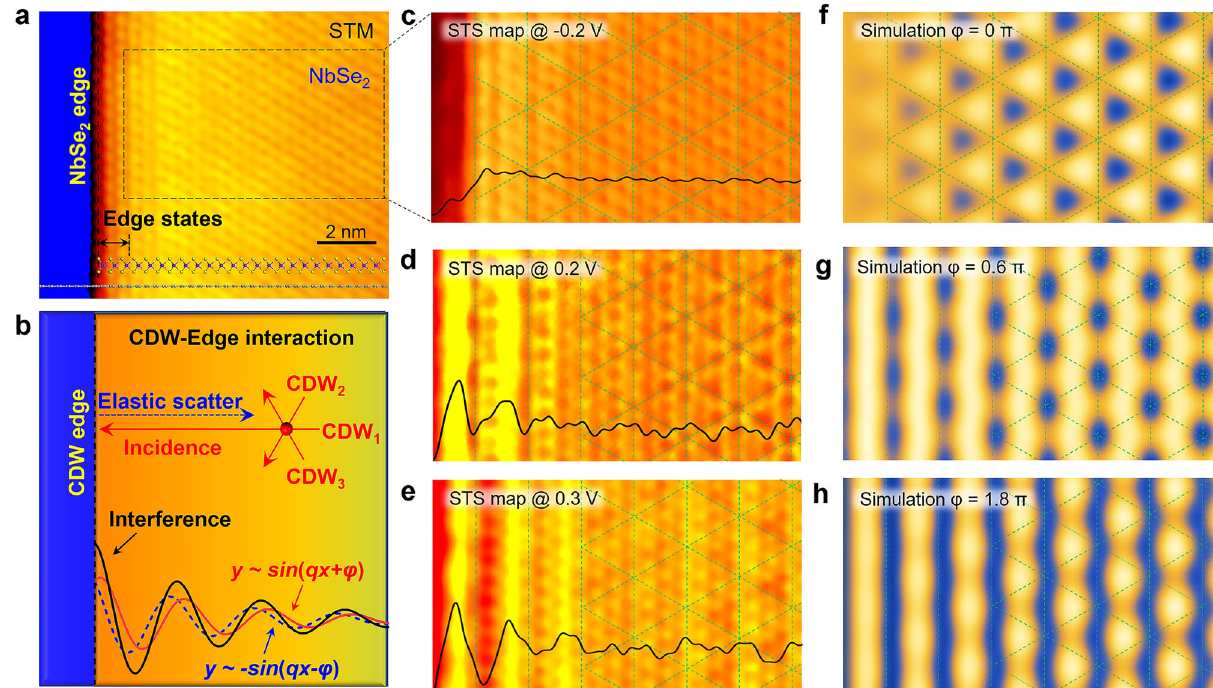
Fig. 4 Charge-density-wave (CDW) orders on the interior of monolayer (ML) NbSe 2 near the well-ordered zigzag (ZZ) edges. a Scanning tunneling microscopy (STM) images at the ZZ edge of ML NbSe 2 . The entire regions exhibit clear 3 × 3 superlattices. The range of edge states are marked in the panel. b Schematic diagram of edge states and edge-CDW interference interactions at the CDW edge. The in-plane CDW modulations can be described as the sum of three individual plane waves CDW 1,2,3 , which are connected by a threefold rotation symmetry. In the direction perpendicular to the edge, the incident and elastic scattered waves can be simpli fi ed to sin ( kx + φ ) and − sin ( kx − φ ), respectively. The interference of the plane waves by the incident and elastic scattered processes results in the stripe-like charge density, depending on the phase φ of the plane wave. c – e Atomically resolved scanning tunneling spectroscopy (STS) maps recorded at the location marked by the black rectangle in panel a under the energies of − 0.2, 0.2, and 0.3 eV, respectively. In the bulk of defect-free NbSe 2 , the CDW contrast in the STS maps always exhibits a 3 × 3 CDW order, along with the strong charge modulation within each CDW supercell. While on the interior of NbSe 2 near the edges, the CDW contrast changes from 3 × 3 CDW orders to nearly one- dimensional stripe phases. f – h Simulations of edge-induced CDW interference with φ = 0 π , 0.6 π , and 1.8 π ,